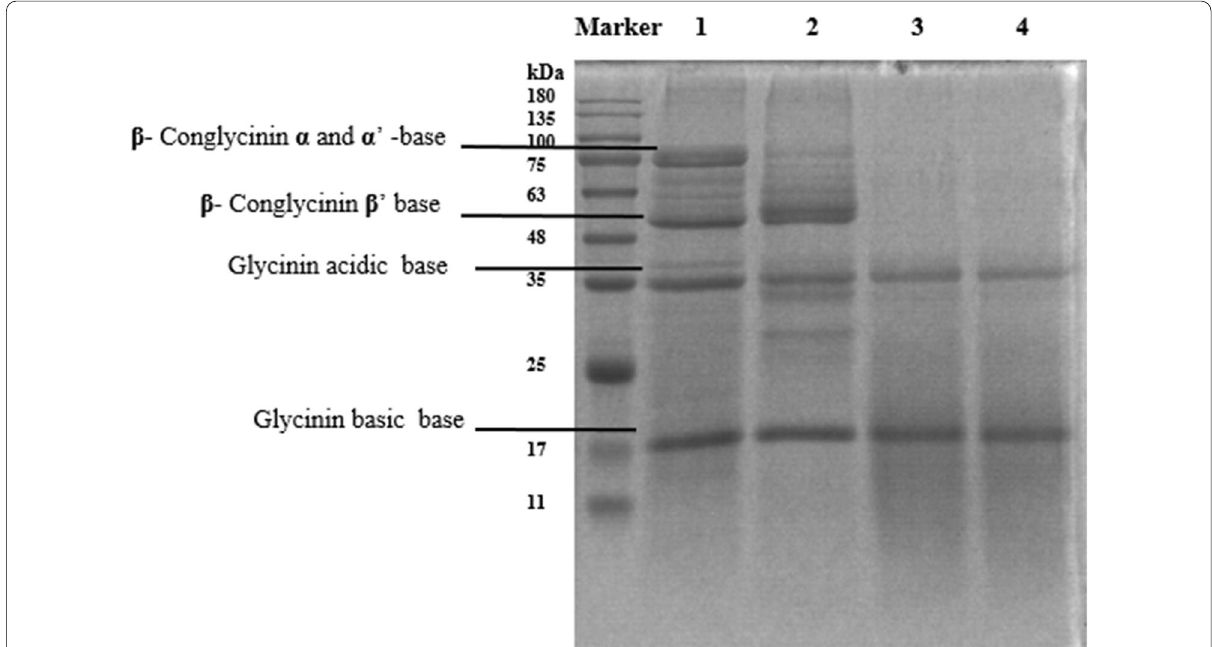
Fig. 3 Effect of degrading glycinin and β-conglycinin of uninoculated SBM and FSBM during two-stage fermentation. Marker: protein molecular weight markers (11–180 kDa); 1: uninoculated SBM; 2: the SBM was inoculated with B. velezensis 157 and fermented at 37 °C for 24 h; 3: the first-stage fermentation was inoculated with B. velezensis 157, incubated at 37 °C for 24 h, then were inoculated with L. plantarum BLCC2-0015 and fermented under anaerobic conditions at 37 °C for another 24 h; 4:the first-stage fermentation was inoculated with B. velezensis 157, incubated at 37 °C for 24 h, then were inoculated with L. plantarum BLCC2-0015 and fermented under anaerobic conditions at 37 °C for another 48 h